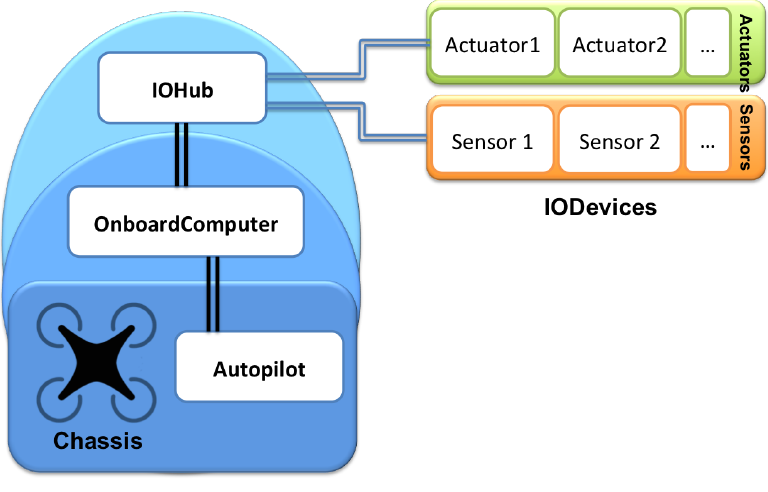
Figure 3. General architecture.